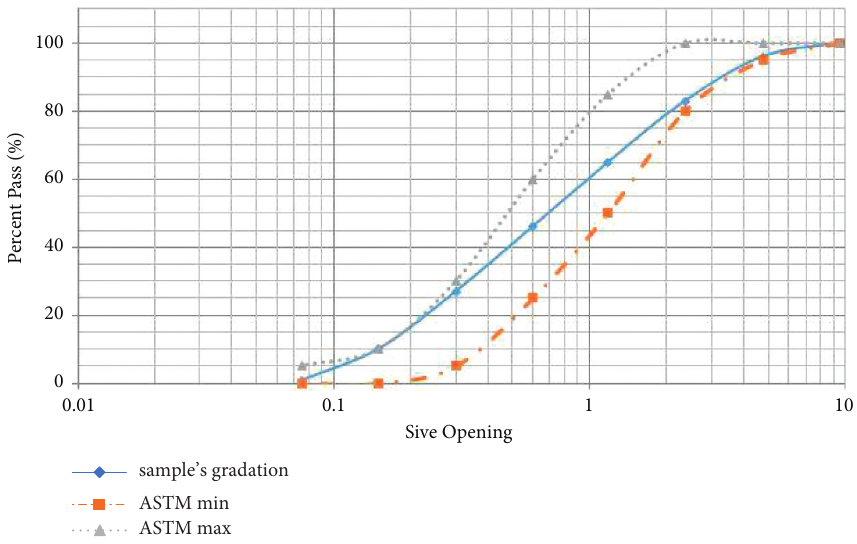
Figure 2: Fine aggregate gradation curve with ASTM limits. Table 2: Properties of fine aggregate used in this study.